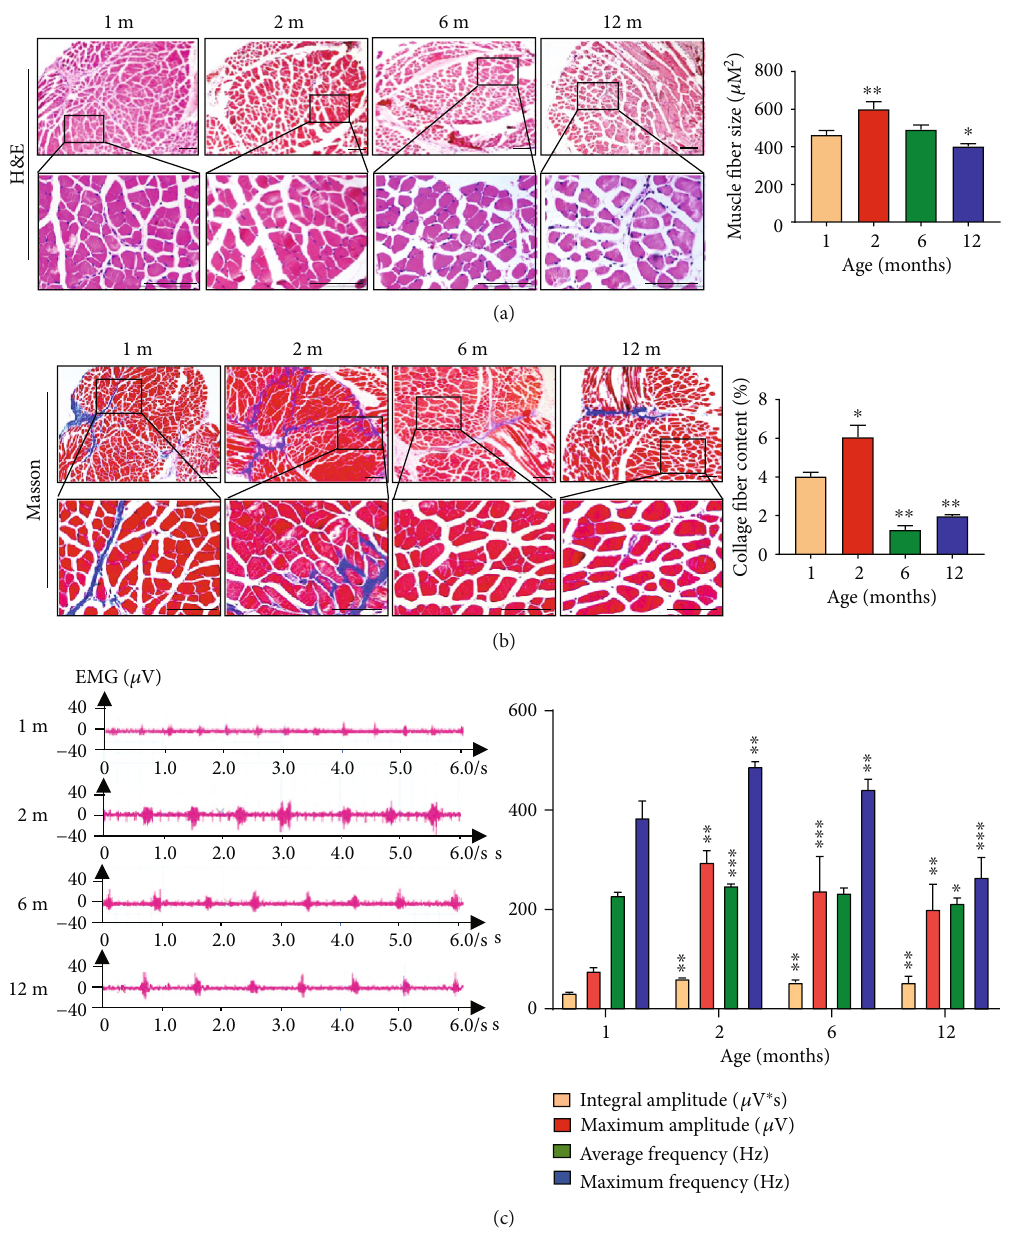
Figure 1: The structure and function of GG declined with aging. (a) The cross-sectional area of muscle fi ber in 2-month-old signi fi cantly increased compared to other age groups. (b) The collagen content of 2-month-old was the highest among four age groups mice. (c) The genioglossus electromyographic activity in four age groups. ∗ p < 0 : 05 , ∗∗ p < 0 : 01 , and ∗∗∗ p < 0 : 001 . Scale bars are 100 μ